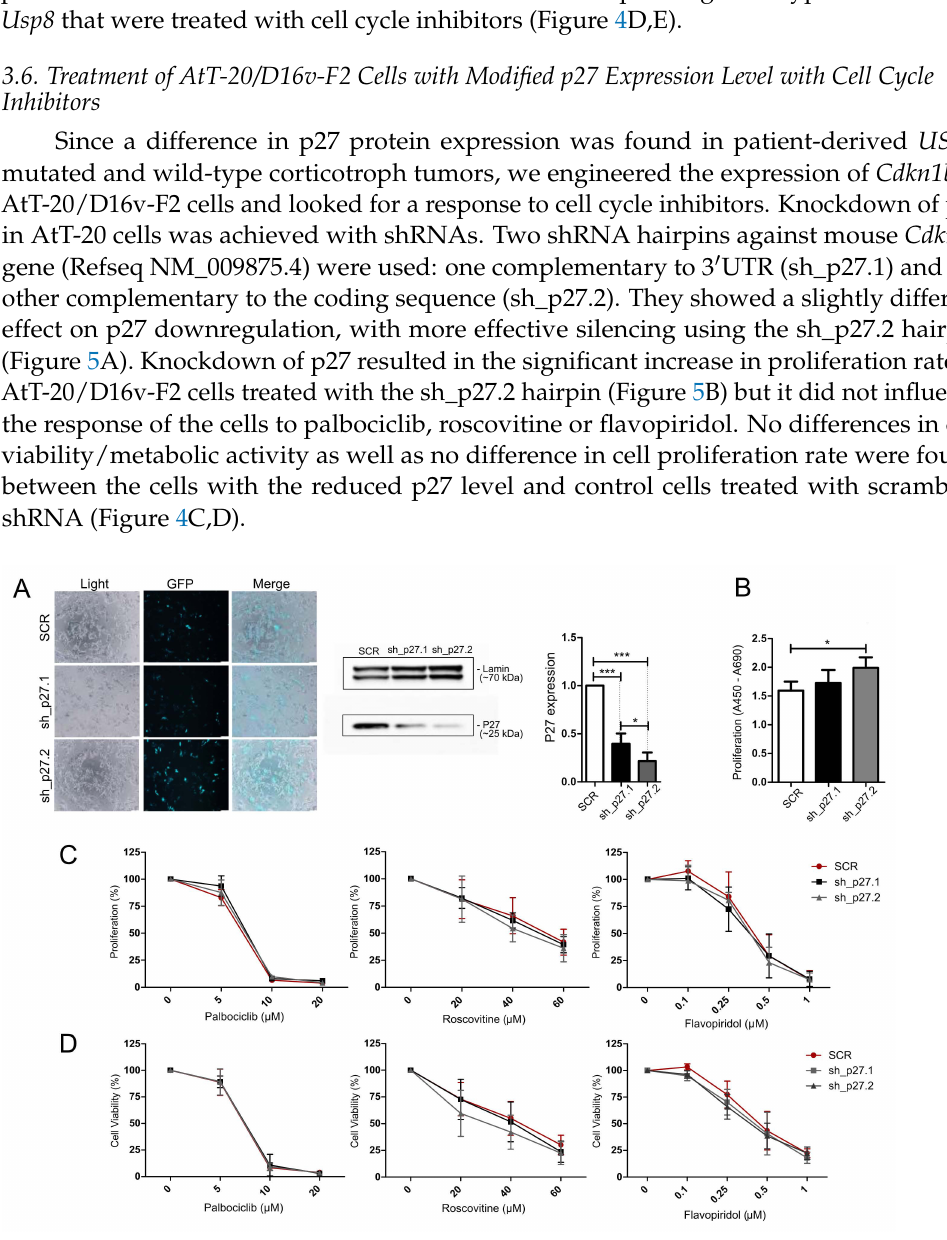
Figure 5. Treatment of AtT-20/D16v-F2 cells with p27 knockdown using cell cycle